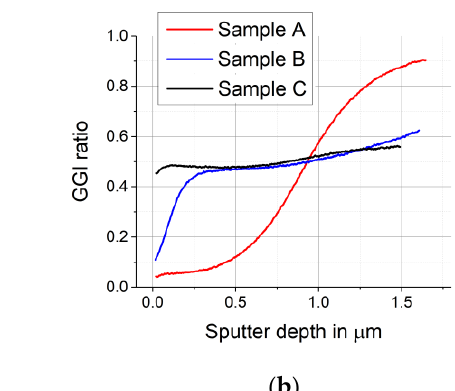
( b ) Figure 7. EDX with different acceleration energies measured from the front and the back. Points give the average between 12 different locations and shaded area represents the standard deviation: ( a ) Ga gradient; ( b ) In gradient. The EDX measurements performed with different acceleration energies exhibit a very small standard deviation between different locations, indicating that the long-range ho- mogeneity is very good. Samples B and C show no significant differences in their Ga and In profiles, even though they were processed with different Se supplies. Only the initial reduction of the Se supply from sample A to B has a great impact on the Ga/In gradients.